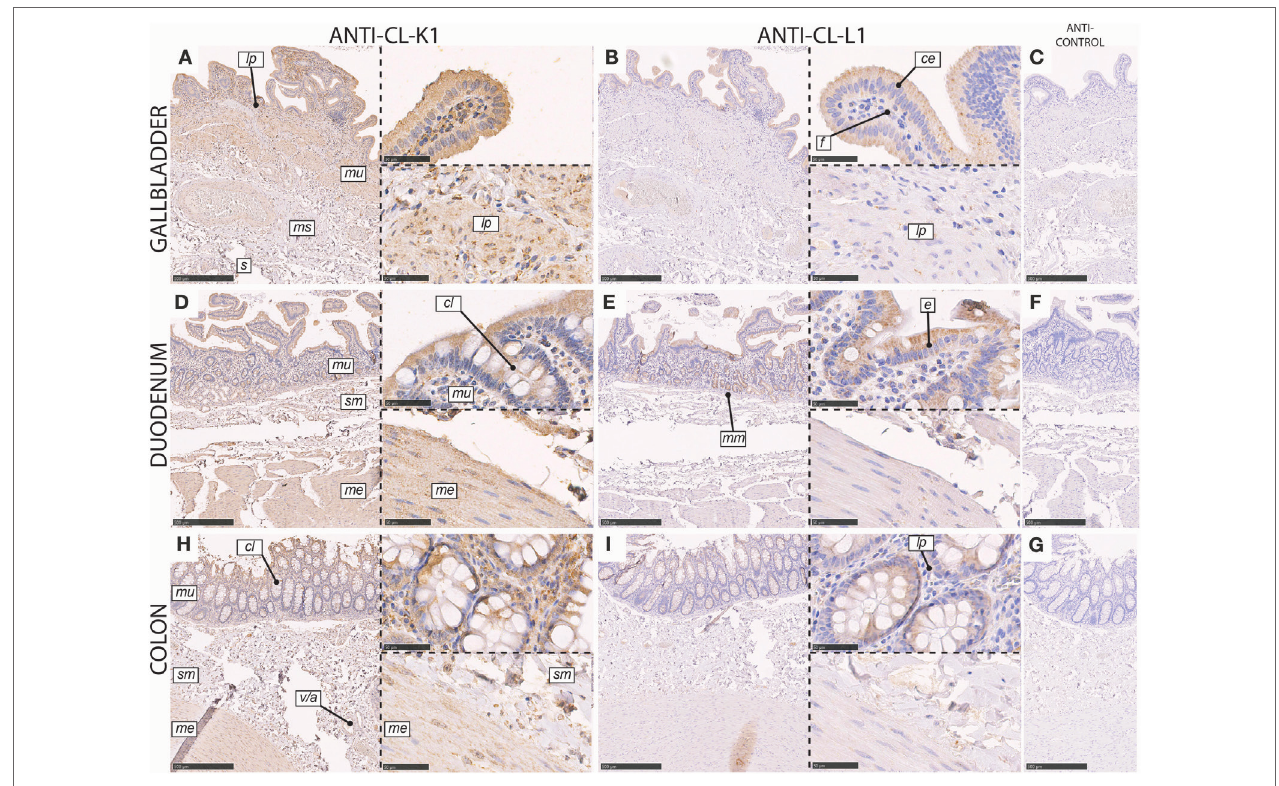
FigUre 5 | Immunohistochemical localization of CL-K1 and CL-L1 in formalin-fixed and paraffin-embedded sections of the gallbladder (a,B) , duodenum (D,e) , and colon (h,i) . Italic letters within images refers to: for the gallbladder s : serosa layer, ms : muscularis layer, m : mucosa layer, lp : lamina propria, ce : columnar epithelial cells, and f : fibroblasts; duodenum and colon me : muscularis externica layers, sm : submucosa, mu : mucosa, cl : crypts of Lieberkuhn (tubular glands), mm : muscularis mucosa, and v/a : vein/artery. Scale bars in large sections and in isotype control sections (c,F,g) correspond to 500 µm and in small sections to 50